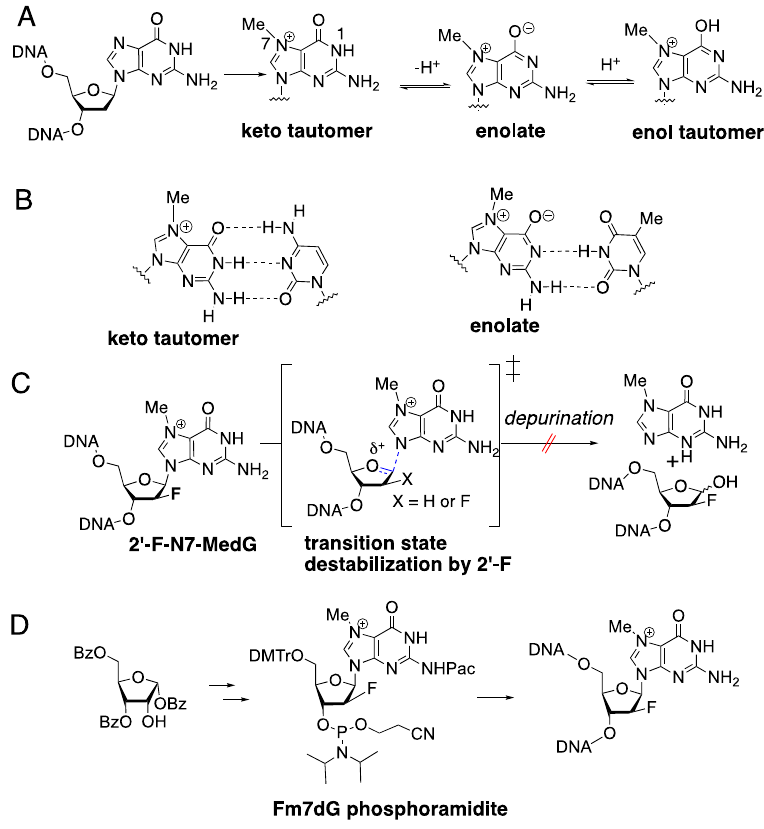
Figure 1. Base-pairing properties of N7-methyl-2-deoxyguanosine (m7dG). ( A ) Methylation of guanine and tautomers of m7dG. ( B ) Base pairings of the keto tautomer and the enolate of m7dG with dC and dT, respectively. ( C ) Prevention of the cleavage of the C–N glycosidic bond of m7dG via transition state destabilization. ( D ) Synthesis of N7-methyl-2 ′ -fluorine-2 ′ -deoxyguanosine (Fm7dG)-containing DNA from a ribose derivative. The 2 ′ -fluorination prevented spontaneous depurination of Fm7dG and allowed site-specific incorporation of the lesion into DNA through solid-phase DNA synthesis and ultramild deprotection (50 mM K 2 CO 3 in methanol at 25 °C).